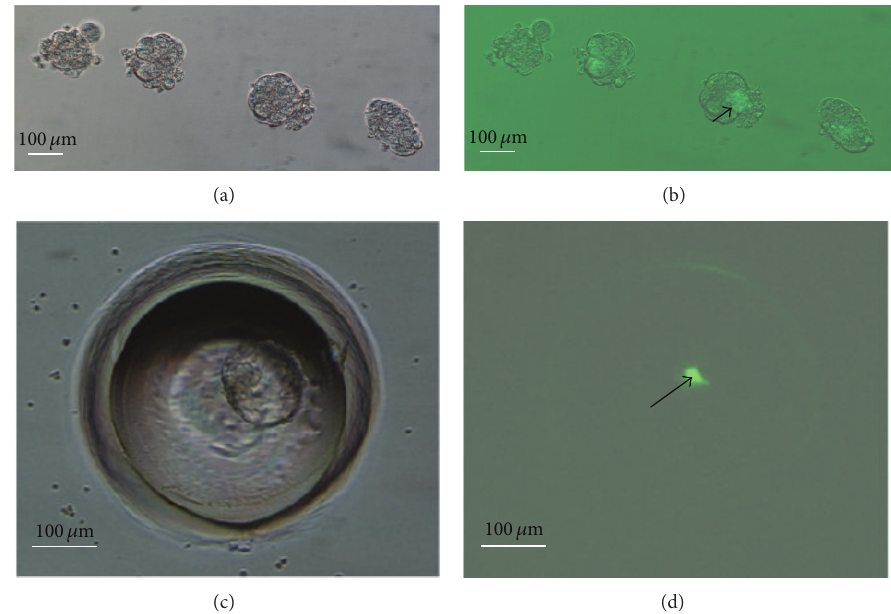
Figure 2: Generation of mouse chimeras by 8-cell embryo coculture with ESCs. Morulae developed from ESC coculture ((a) bright field; (b) GFP fluorescence); the arrow shows that ESCs were aggregated into the recipient embryos. Blastocysts developed from ESC coculture in the WOW system ((c) bright field; (d) GFP fluorescence). The arrow shows how ESCs were aggregated into the ICM of recipient embryos.